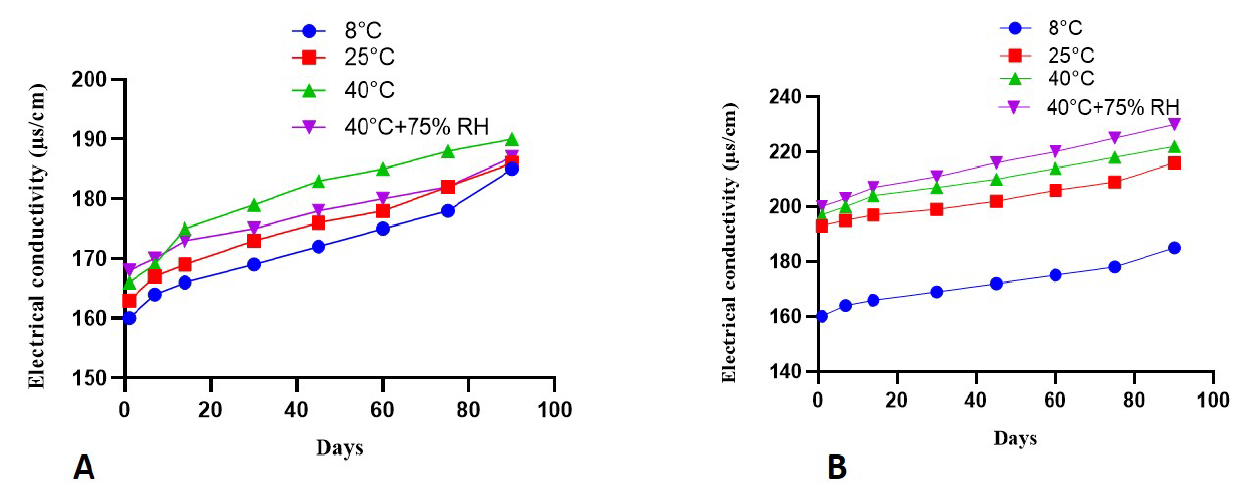
Figure 5. Change in electrical conductivity of ( A ) (placebo) and ( B ) (formulation) with time kept at different storage conditions (mean ± SD, n = 3).